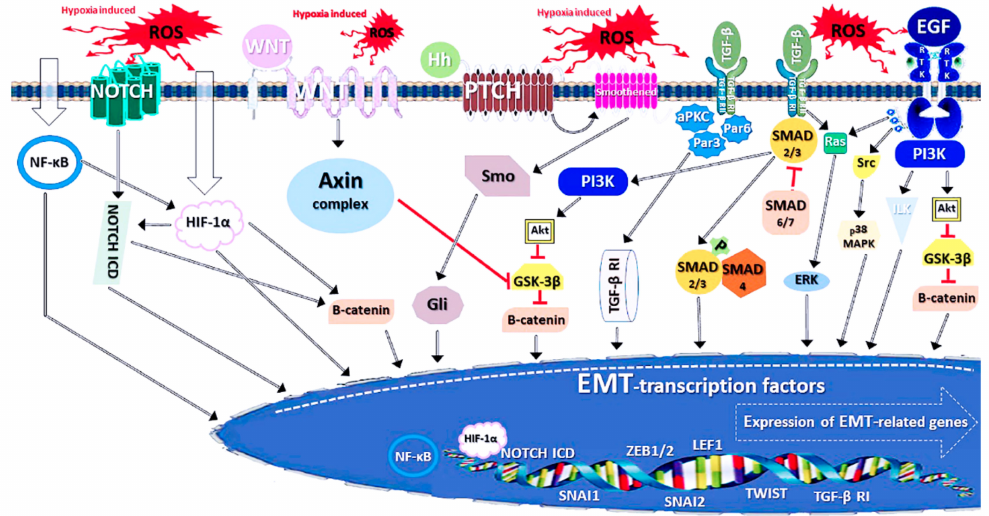
Figure 3. The known OS-dependent mechanisms of epithelial-to-mesenchymal transition (EMT), represented in simplified terms. These include signalling mediated by transforming growth factor β (TGF- β ), growth factor / RTK (here epidermal growth factor; EGF), Hedgehog (Hh)-Smoothened receptor, WNT (“Wingless / Integrated) receptor, NF- κ B, HIF-1 α and NOTCH receptor. Here, the arrows pointing from the signalling routes to the EMT transcription factors (not an exhaustive collection) to the DNA in the nucleus are grouped. More specific information about the activations of certain transcription factors can be found in reviews in the literature. The mechanisms of HIF-1 α activation by hypoxia-induced reactive oxygen species (ROS) in the far left of the figure, are still somewhat tentative and beyond the scope of this review. Abbreviations: ERK, extracellular signal-regulated kinase; Gli, Gli family transcription factor; Hh, hedgehog; ICD, intracellular domain; ILK, integrin-linked kinase; LEF, lymphoid enhancer-binding factor; p38 MAPK, p38 mitogen-activated protein kinase; Par, partition defective; PTCH, patched homologue receptor; RTK, growth factor / receptor tyrosine kinase; Smo, smoothened (intracellular); SNAI, Snail family Zn-finger transcription factor; ZEB, Zeb family Zn-finger transcription factor. Other abbreviations are included in the list of